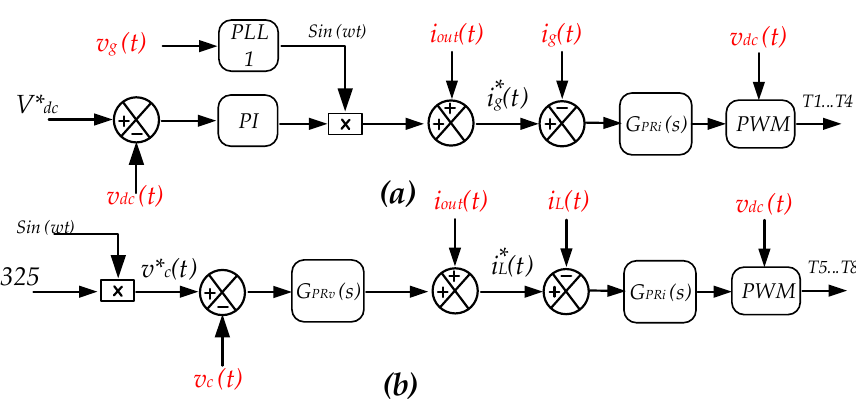
Figure 3. The conventional control system structure of the ER primary grid-side VSI1 control ( a ) and output side grid-forming VSI2 control ( b ) .